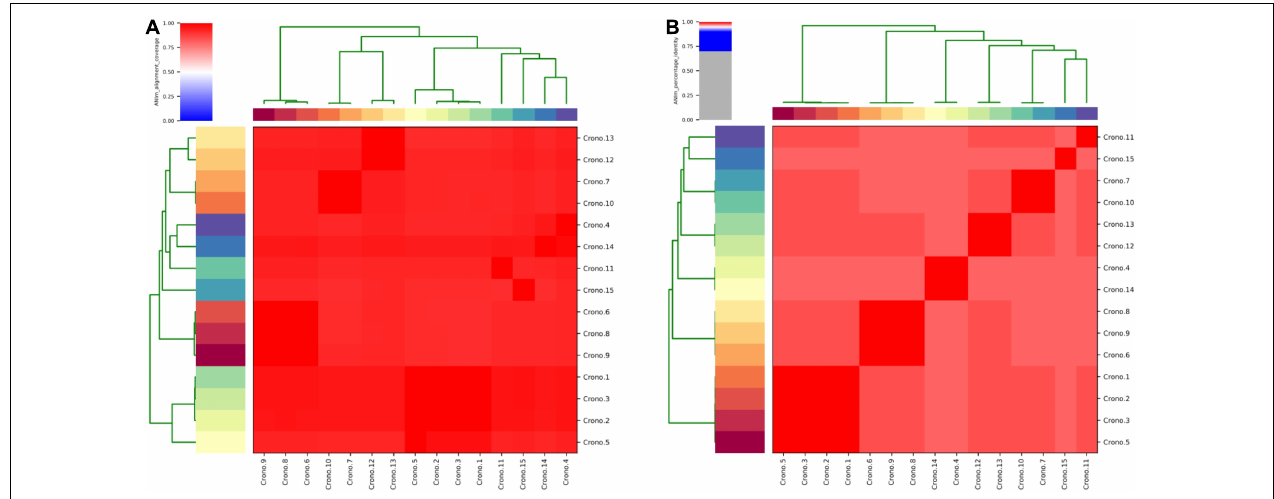
FIGURE 2 | Average nucleotide identity (ANI) analysis of all 15 C. sakazakii genomes. (A) Heat map of the ANIm coverage for the studied genomes. The 15 genomes assignments as indicated at the source are given as row and column labels. Cells in the heat map corresponding to 50% coverage or greater are marked in red. Blue cells correspond to coverage of 50% or less. Color intensity fades as the comparisons approach 50% coverage. Color bars above and on the left of the heat map correspond to isolate ID for each genome in the analysis. Hierarchical clustering of the data in two dimensions is represented by dendrograms, constructed by simple linkage of ANIm percentage identities. This analysis identifies a single with a minimum aligned genome length above 50%. (B) ANIm percentage identity for the studied genomes. The 15 genomes as indicated at the source are given as row and column labels. Cells in the heat map corresponding to 95% ANIm sequence identity are colored red. Color intensity fades as the comparisons approach 95% ANIm sequence identity. Color bars above and to the left of the heat map correspond to isolate ID for each genome in the analysis. Hierarchical clustering of the analysis results in two dimensions is represented by dendrograms, constructed by simple linkage of ANIm percentage identities. The analysis indicates a single-level clade along the heat-map diagonal at the 95% identity threshold, suggesting that the current 15 studied Cronobacter genomes have a high sequence similarity at the nucleotide level.